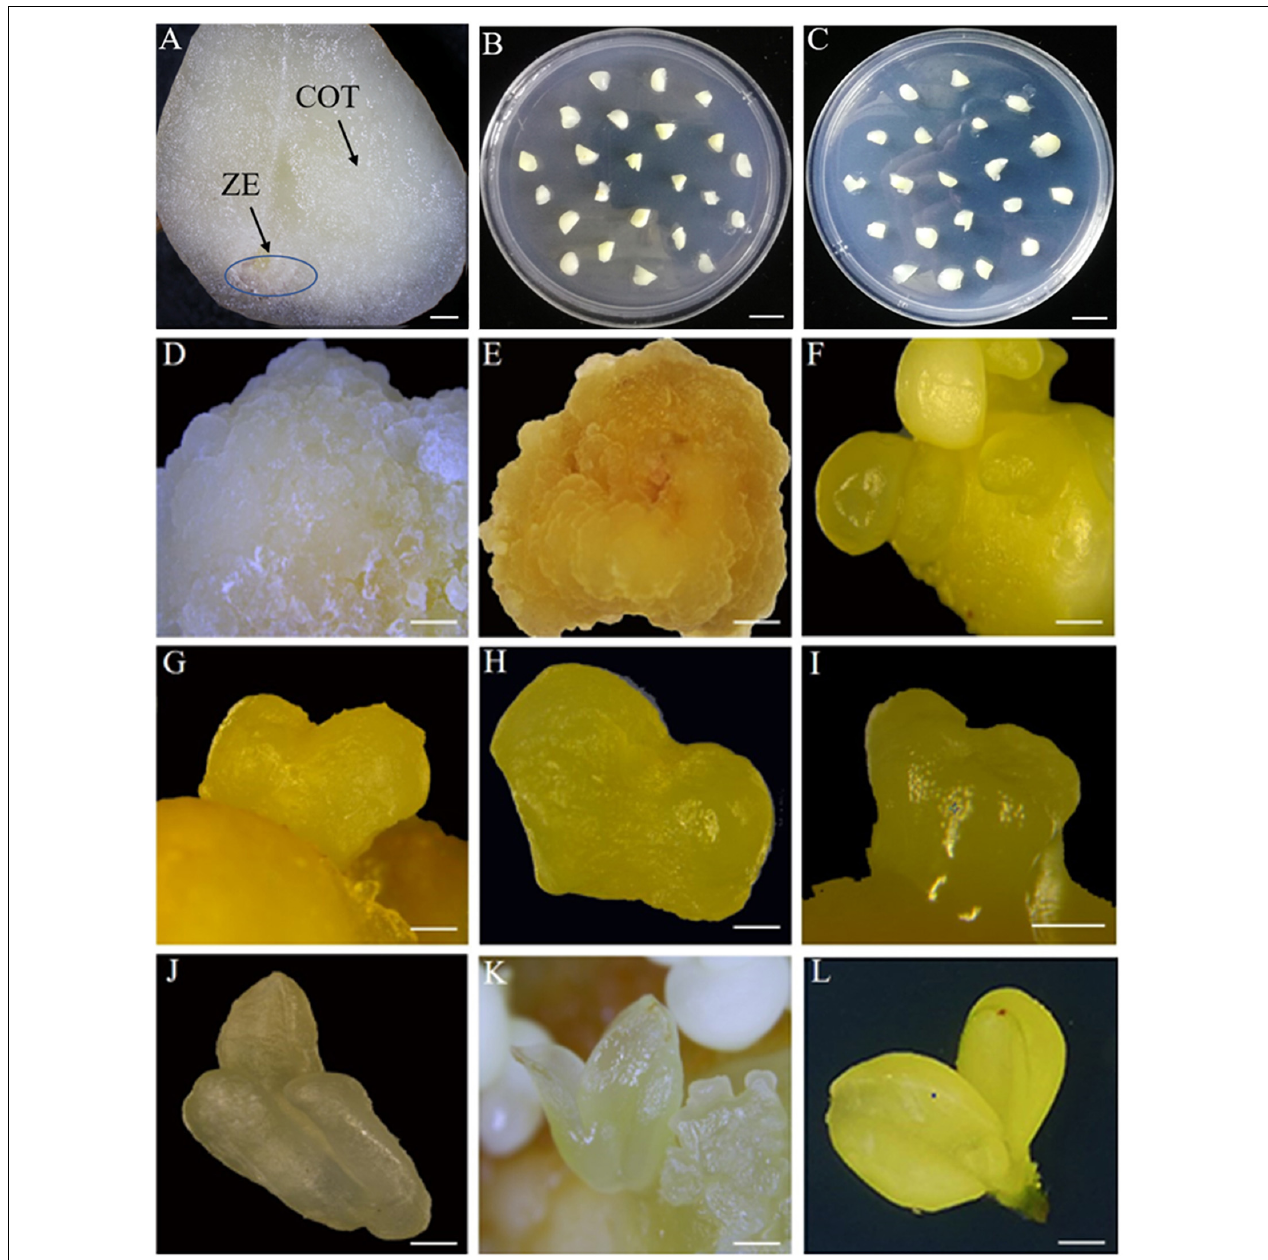
FIGURE 2 | The observation of indirect somatic embryogenesis pathway at different developmental stages. (A) Zygotic embryonic axis (ZE) and cotyledons (COT) of immature seeds. (B) Zygotic embryonic axis inoculated in MS medium. (C) Cotyledons inoculated in MS medium. (D) Non-embryogenic calli 50 days after inoculation. (E) Embryogenic calli 50 days after inoculation. (F) Globular embryo 70 days after inoculation. (G,H) Heart embryo 75 days after inoculation. (I,J) Torpedo embryo 80 days after inoculation. (K) Cotyledonary embryo 85 days after inoculation. (L) Mature cotyledonary embryo 100 days after inoculation. Bars: (A) = 800 µ m, (B,C) = 10 mm, (D,E,L) = 2 mm, (I) = 0.5 mm, and (F,G,H,J,K) = 1